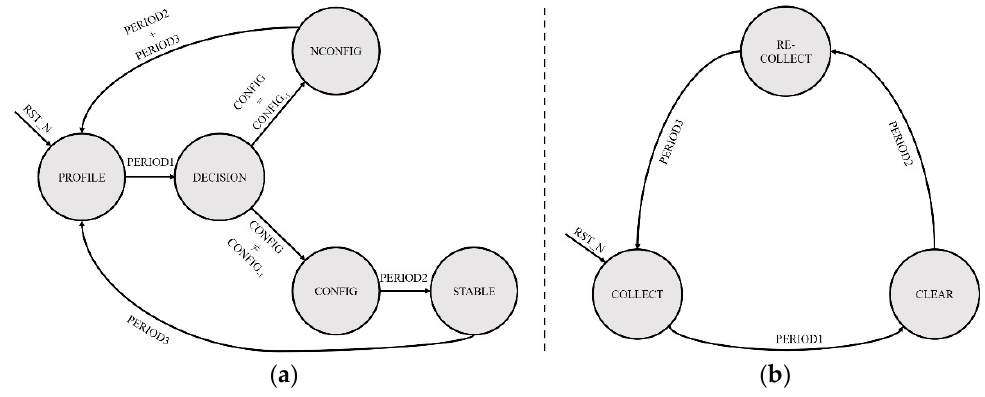
Figure 9. State transition diagrams: ( a ) state transition diagram of adaptive controller; ( b ) state transition diagram of performance monitor.